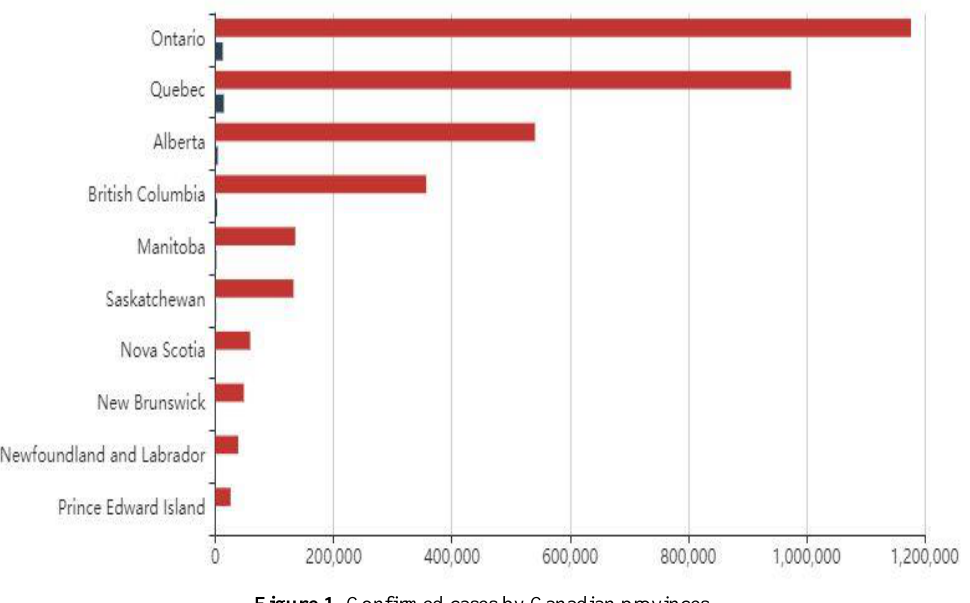
Figure 1. Confirmed cases by Canadian